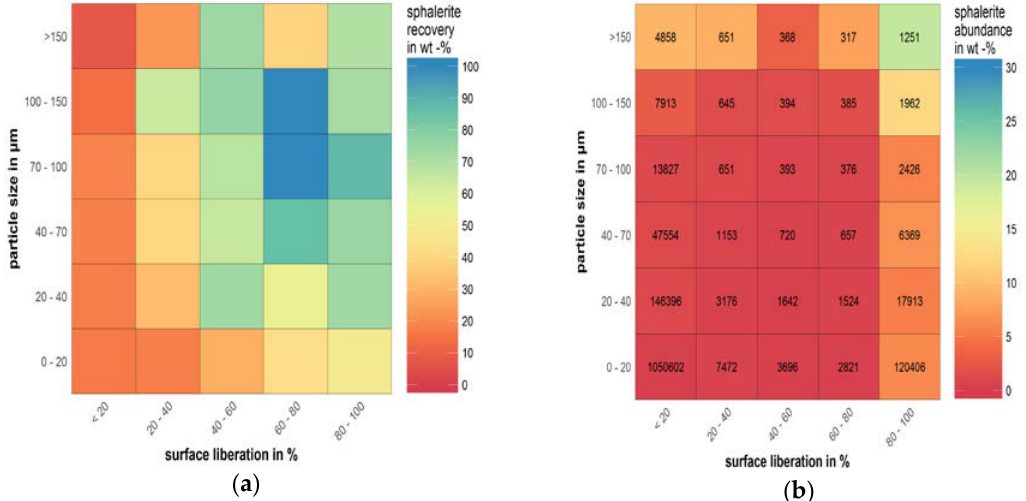
Figure 6. Sphalerite recovery by size and liberation ( a ), sphalerite abundance and particle count ( b ) for both varieties combined.